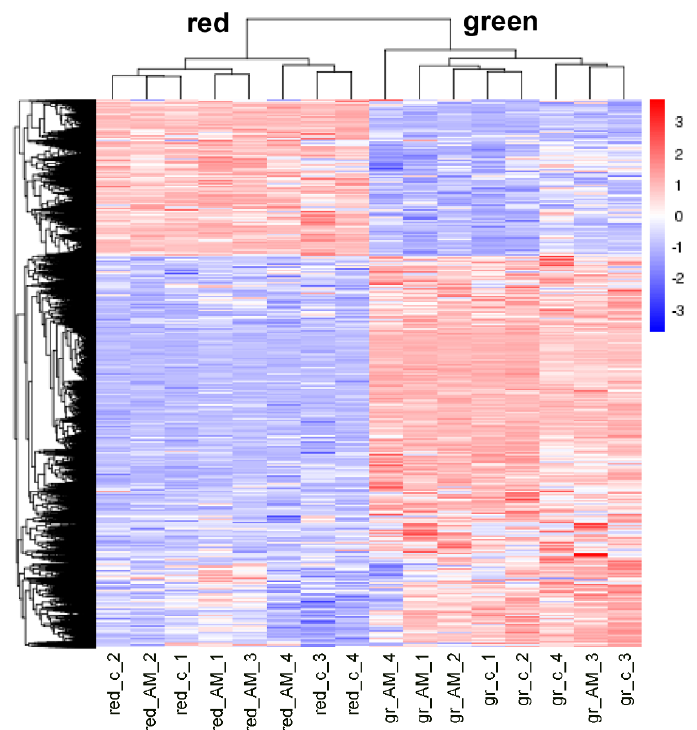
Figure 3. Heatmap showing hierarchal clustering of differentially expressed genes (DEGs). Clustering was performed using log10 (FPKM + 1)-values of DEGs between green (gr) and red fruits of mycorrhizal (AM) and non-mycorrhizal (c) plants ( n = 4, p < 0.05). Colors visualize column-scaled Z-score from low (blue) to high (red) gene expression.